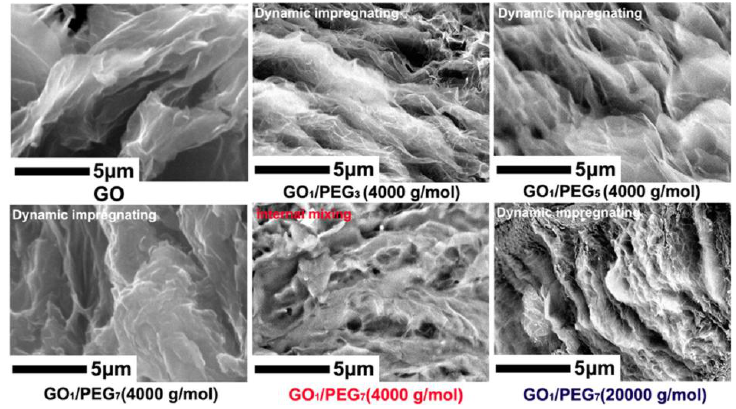
Figure 2. Scanning electron microscope (SEM) images of GO and the hybrid GO/PEG composites with different component ratio under different premixing method.